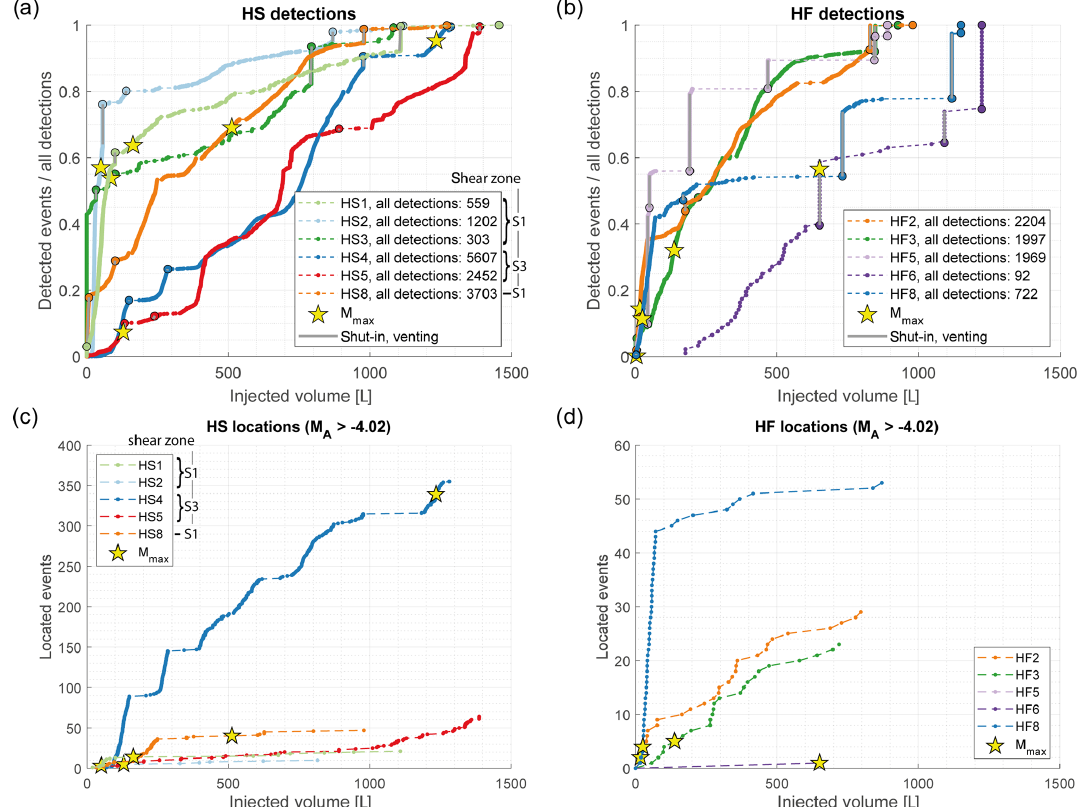
Figure 5. Cumulative fraction of detected events as a function of cumulative injected volume of (a) HS and (b) HF injection experiments. Panels (c) and (d) show absolute values of located events above a magnitude level of M A − 4 . 02 (maximum M C in the experimental volume; see Sect. 4.3) for HS and HF experiments, respectively. Note that for experiment HS3 only one event was observed above the maximum M C in the experimental volume and is thus not shown in Fig.